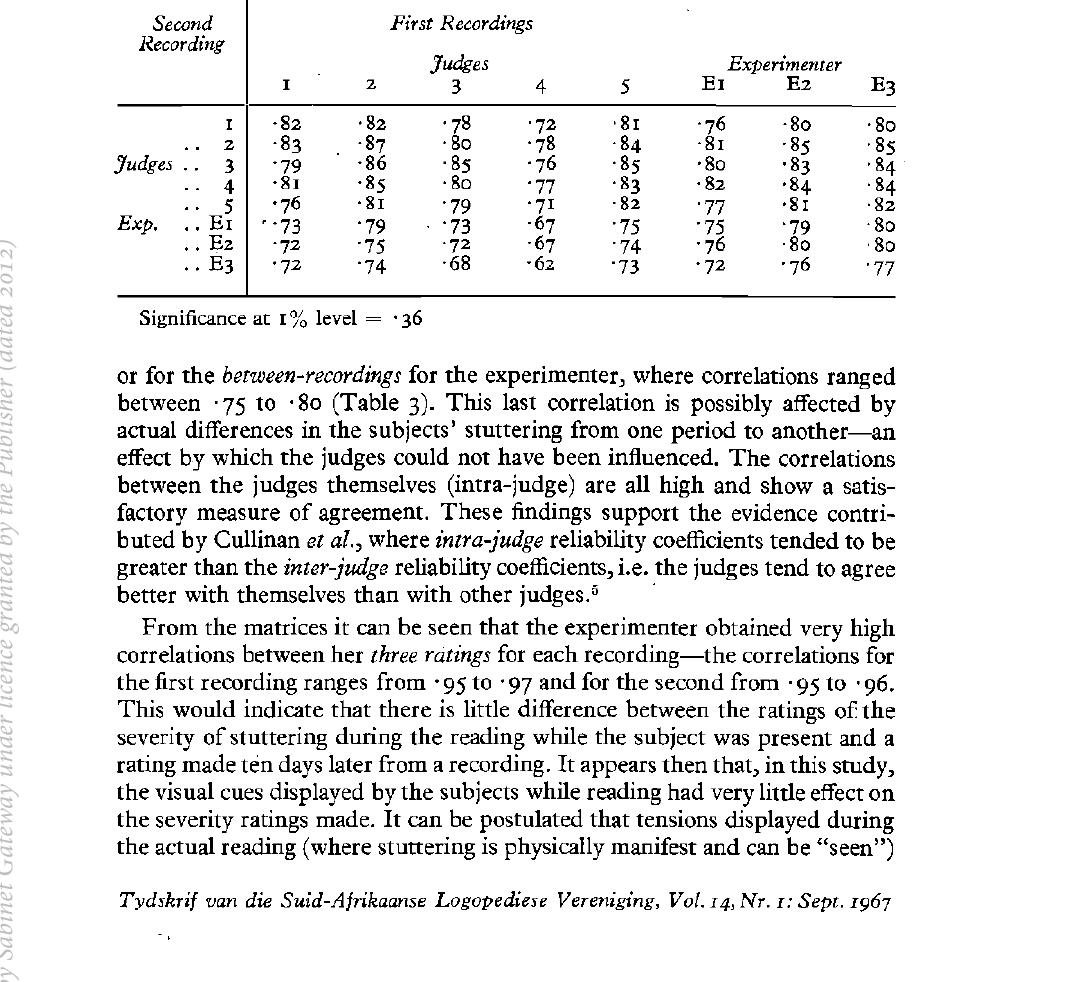
TABLE 3: INTER-CORRELATIONS OF THE SEVERITY RATINGS OF STUTTERING MADE BY FIVE JUDGES AND THE EXPERIMENTER BETWEEN THE T wo GROUPS OF RECORDINGS HEARD Second